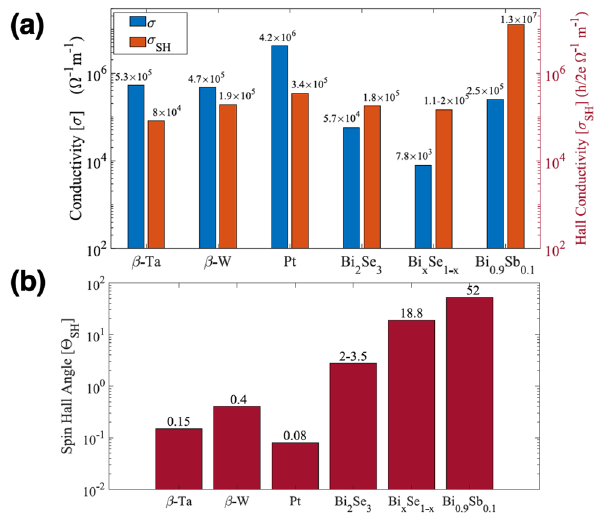
Fig. 6 Benchmarking SOT materials. a Conductivity ( σ ) and spin Hall conductivity ( σ SH ) and b the resultant spin Hall angle θ SH for several prominent strongly spin – orbit coupled metals ( β -Ta, β -W, and Pt) shown in conjunction with common TI materials. While TIs are not as conductive as the metals, due to their comparatively large band gap, they may produce spin Hall conductivities that exceed those of metals. The signi fi cant improvement that TIs offer in spin to charge ef fi ciency is captured in the spin Hall angle where it may be as much as two orders of magnitude larger than comparable metals. Both fi gures are adapted from ref. 74 . Reprinted by permission from ref. 74 , copyright